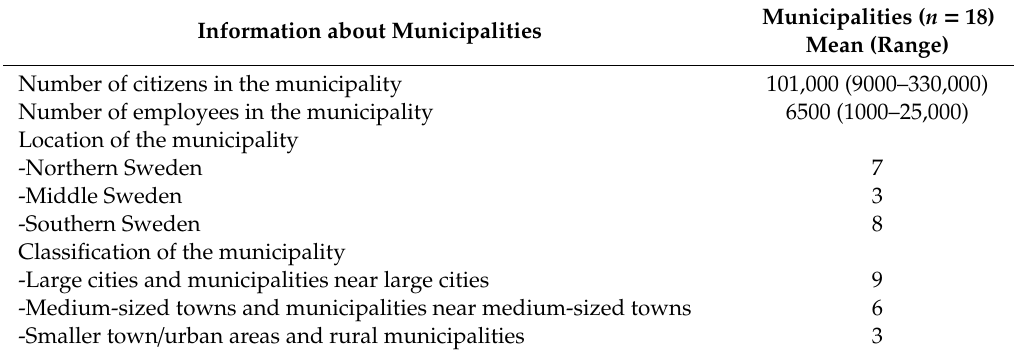
Table 1. Information about